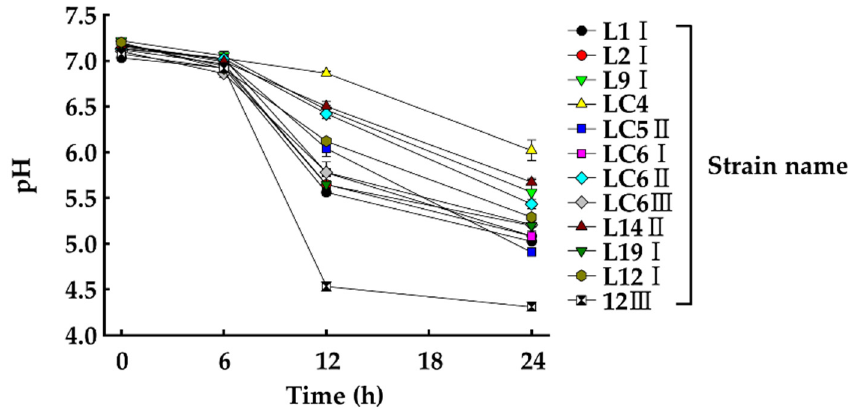
Figure 2. Changes of pH in culture medium of candidate bacterial strains. Values represent the mean ± S.E. ( n = 3).